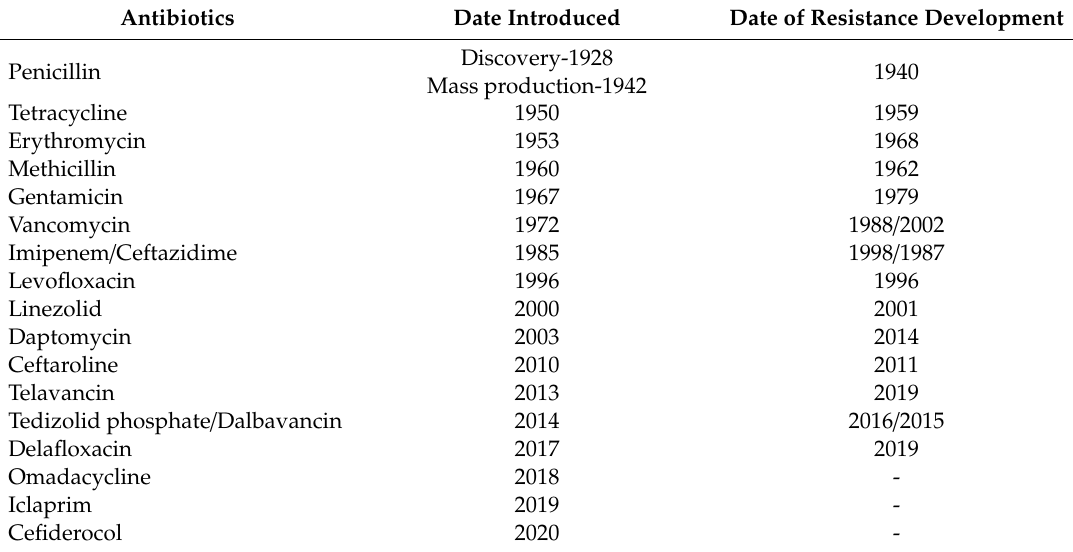
Table 1. A timeline of antibiotic introduction and the development of antibiotic